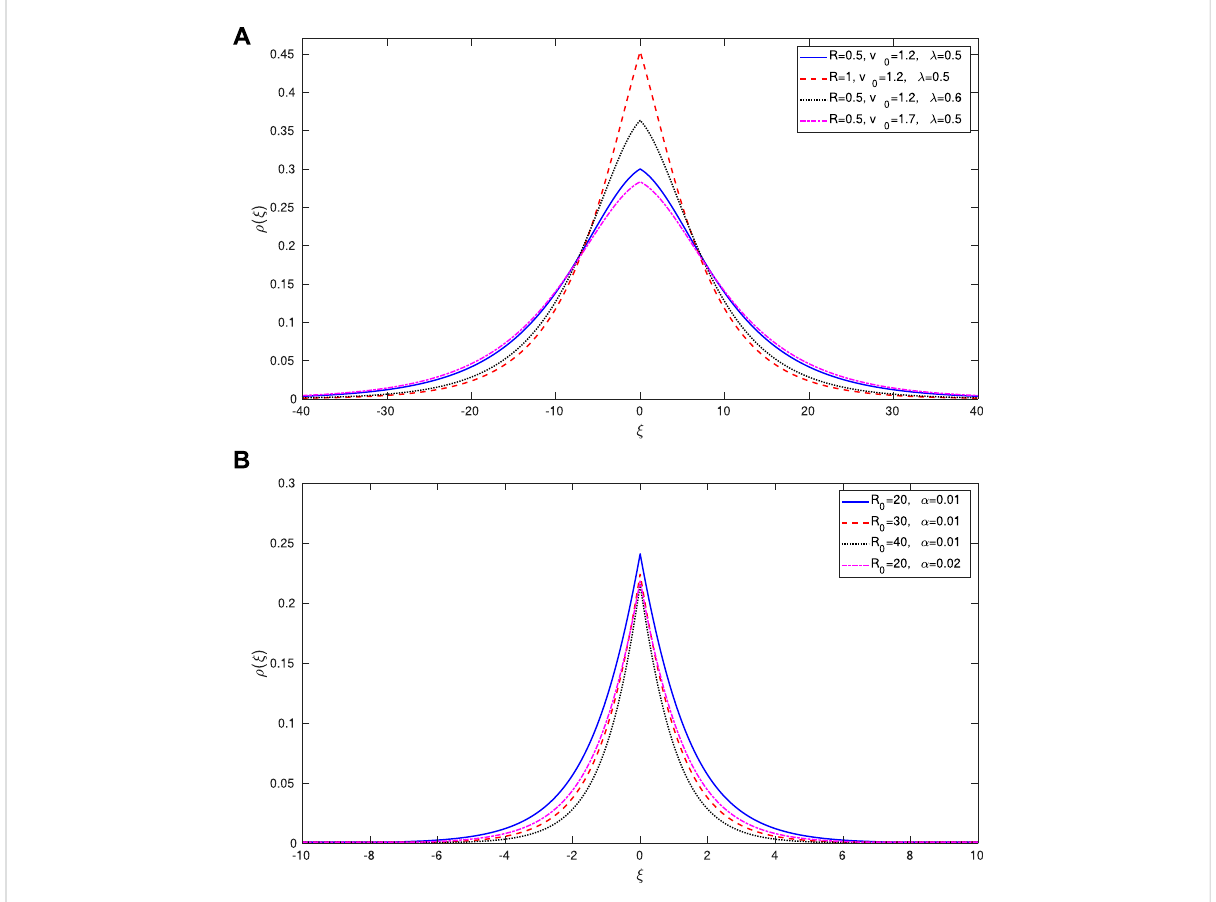
FIGURE 2 Two branches of soliton solutions [Eq. 19], symmetric about the origin, are plotted against ξ with a fi xed α = 0.01 and different values of the parameters as in the legends. While subplot (A) is shown for a moderate value of R 0 , subplot (B) is for relatively a higher value of R 0 . The soliton characteristics are signi fi cantly modi fi ed due to different degrees of relativistic